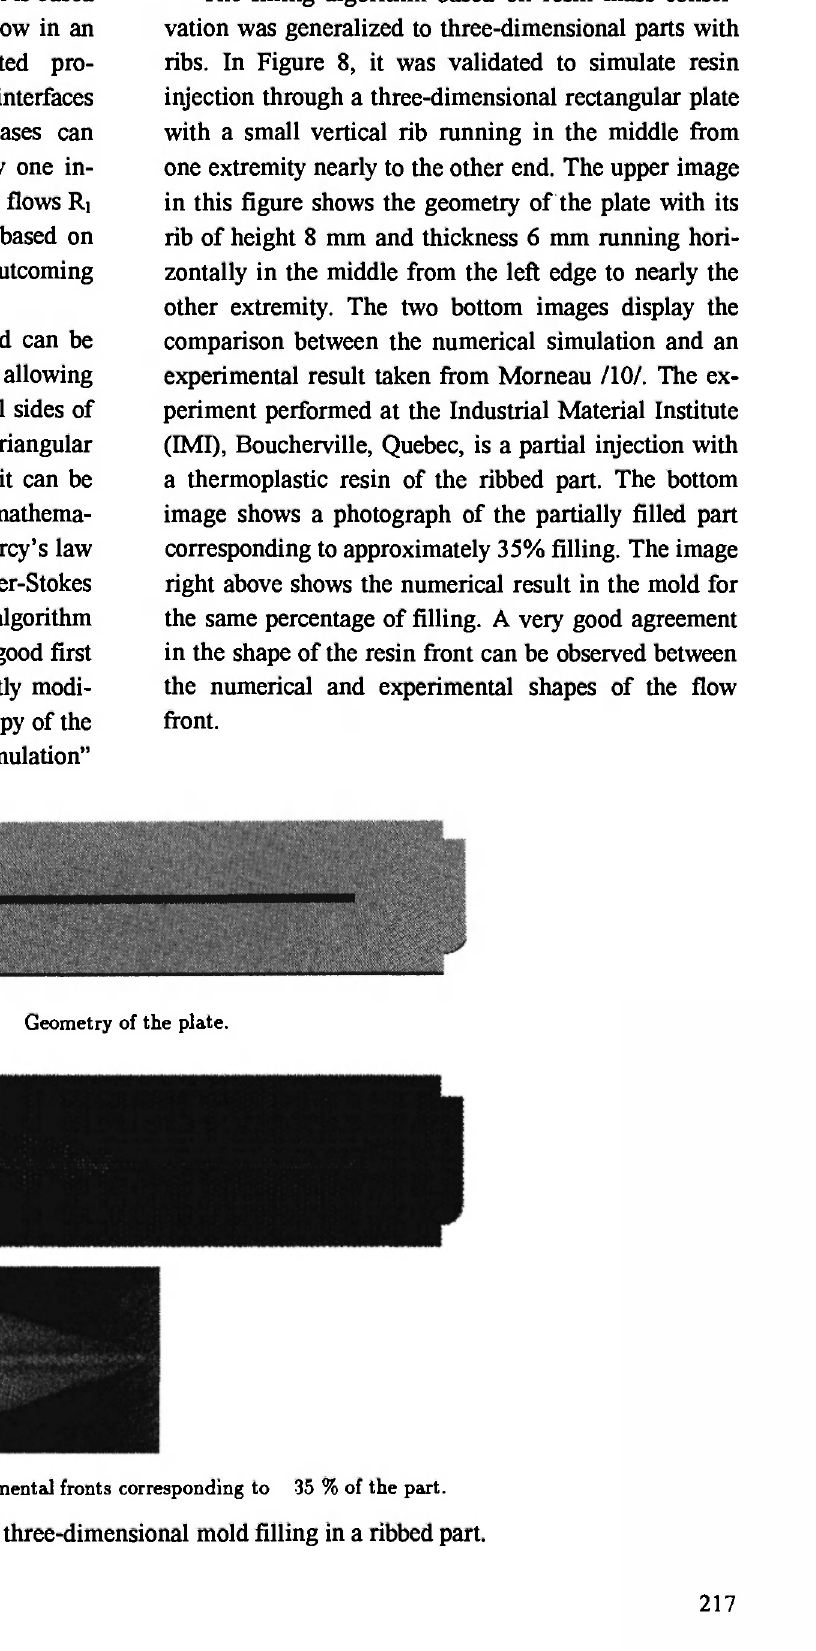
Fig. 8: Validation of three-dimensional mold filling in a ribbed